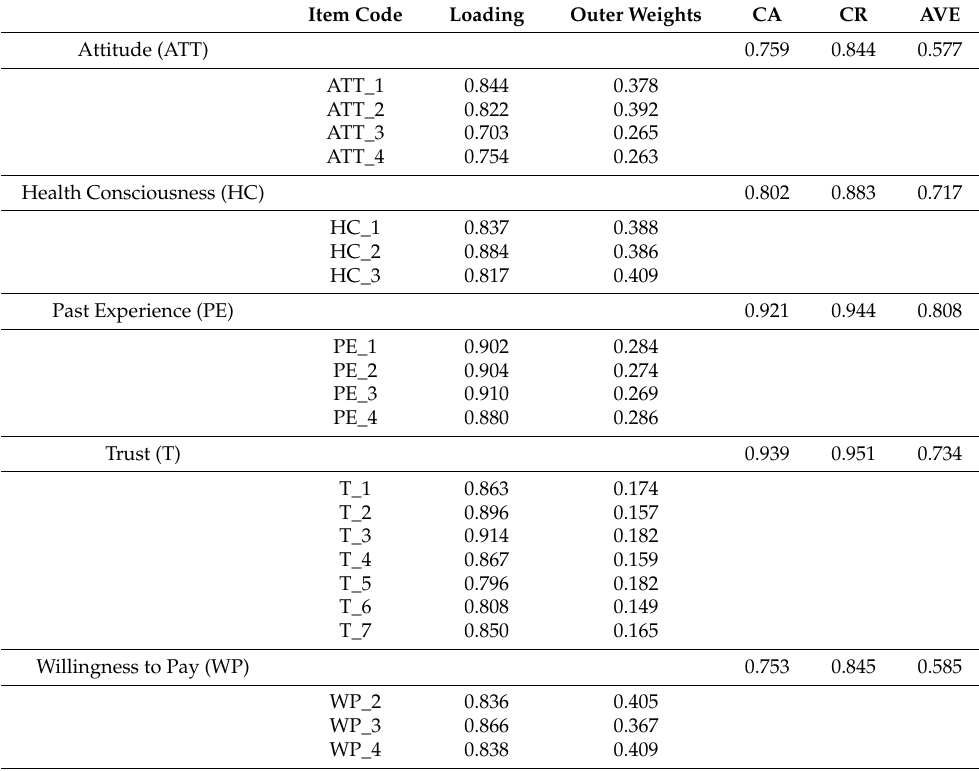
Table 2. Reliability and